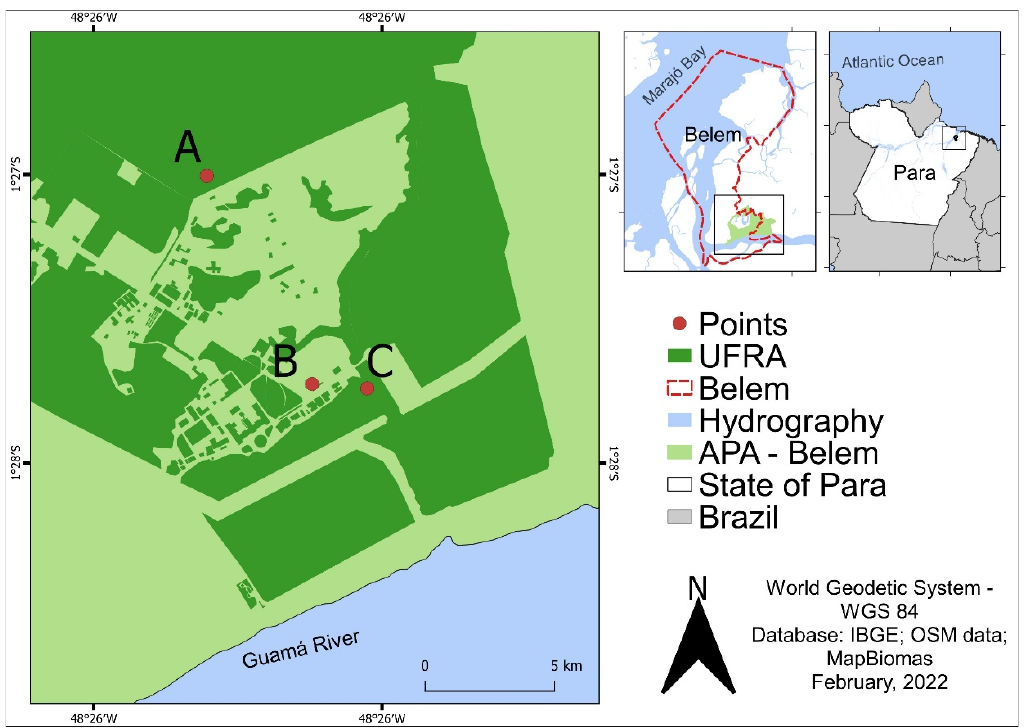
Figure 1. Location of the UFRA inside the APA-Belem (Pará, Brazil), with the demarcation of points for collecting hematophagous arthropods (A and C) and capturing free-ranging birds (B and C). A—Animal Husbandry sector. B and C—Veterinary Medicine sector.